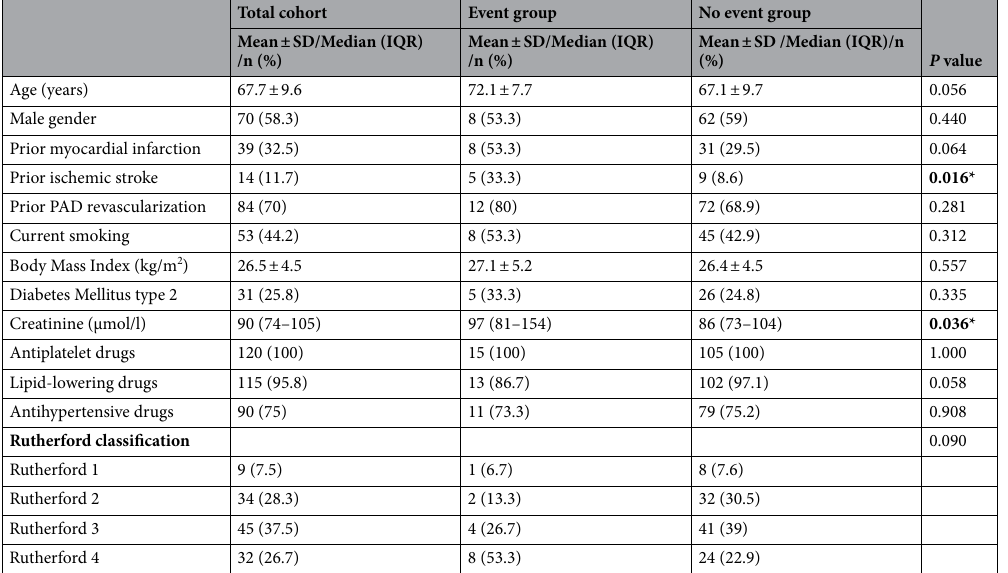
Table 1. Baseline characteristics for the whole cohort and distribution between patients with and without cardiovascular events during follow-up. Significance was reached when p < 0.05 (*). Significant values are in